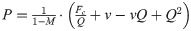
The price-quantity function.We have used the following function P=11-M·(FcQ+v-vQ+Q2), to relate the price of the product with the quantity supplied, where P is the selling price of the product (cost + profits) and Q is the quantity of production. The average fix cost function is FcQ where Fc is a positive constant and the average variable cost function is v − vQ+Q2, where v is positive constant. The parameters are fixed as: Fc = 10 and v = 4. The supply curves S (solid line), S1 (dot line) and S2 (dash-dot line), correspond to the gross margin M = 0.5, M = 0.8, M = 0.2 respectively. When the firm increases the gross margin M, the price increases and when the firm reduces the gross margin M the price decreases.